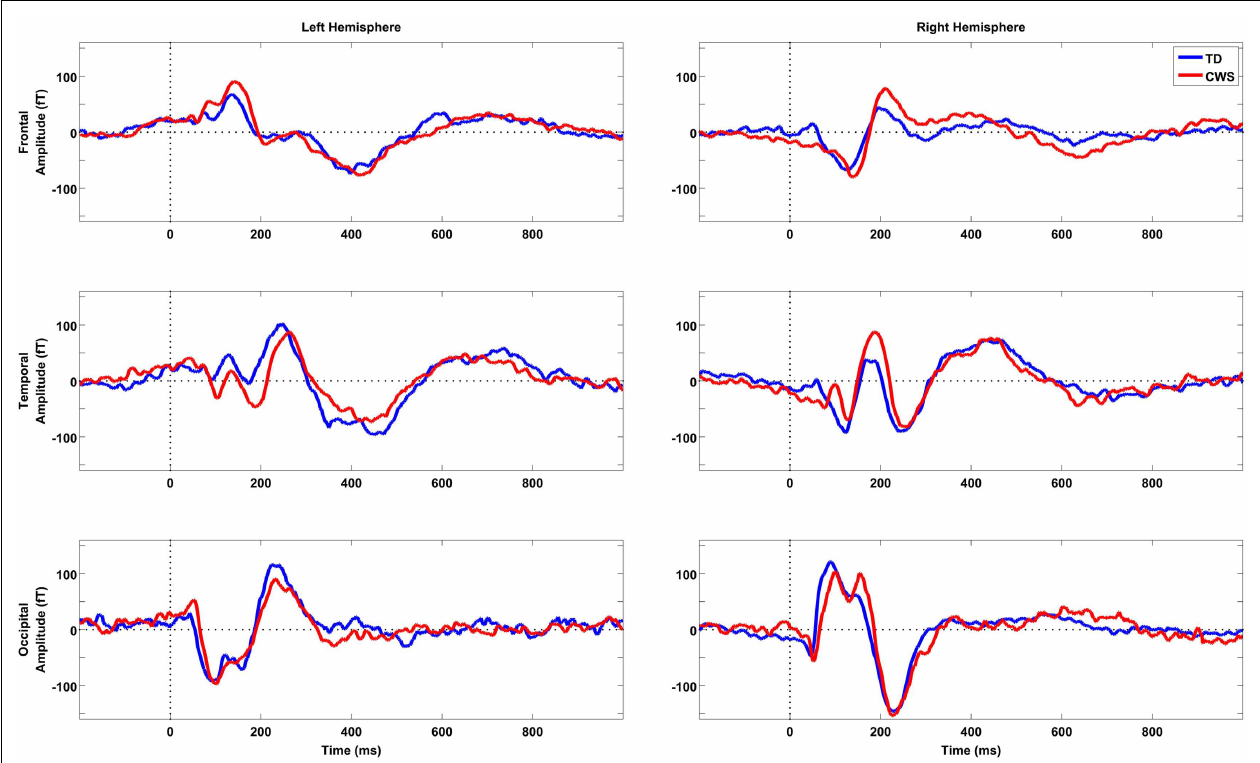
FIGURE 1 | Grand mean sensor space activations for six sample sensors taken from frontal, temporal, and occipital locations in the left and right hemispheres, respectively .TD subjects are depicted in blue ( n = 12) and CWS in red ( n = 12).Vertical dotted lines represent picture-naming stimulus onset